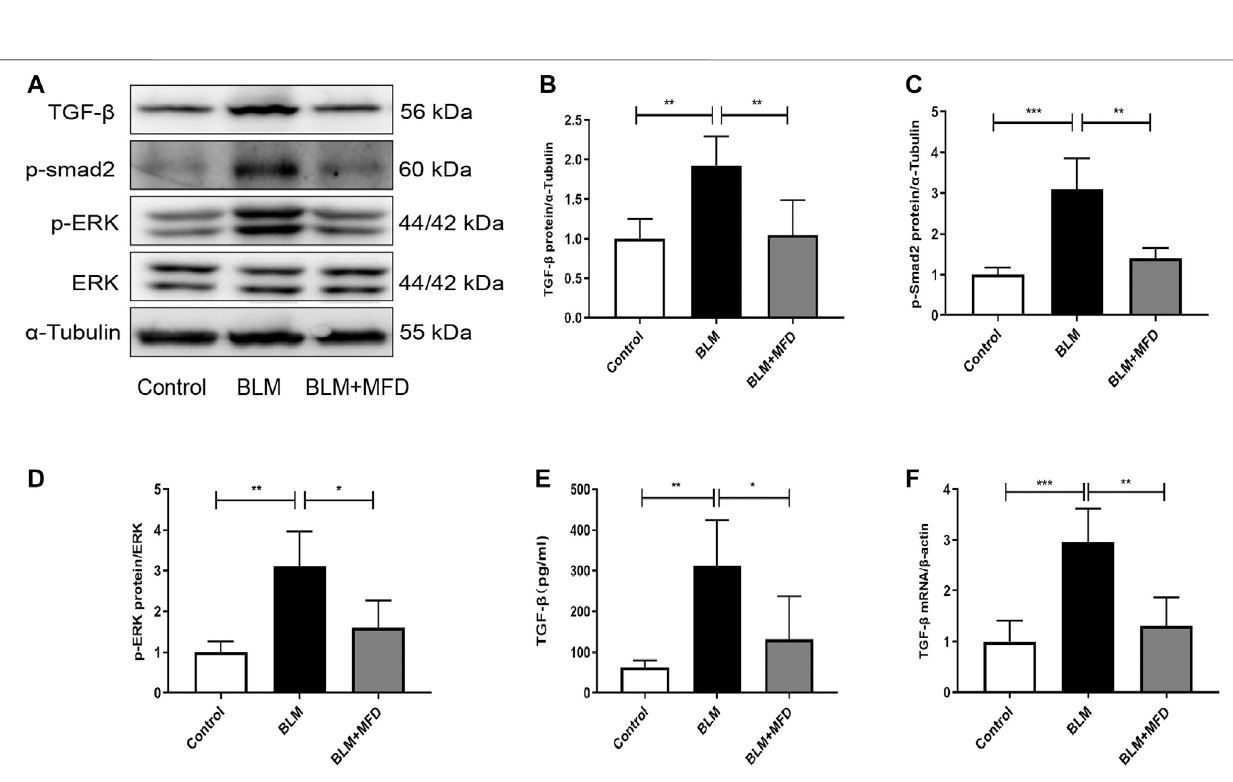
Frontiers in Pharmacology |